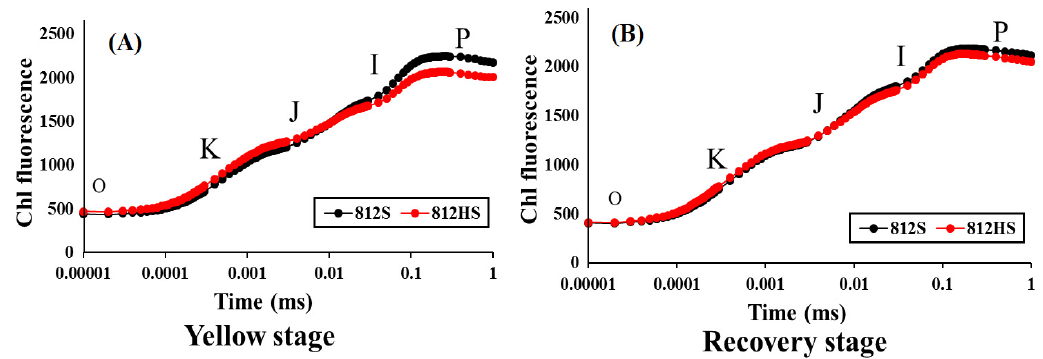
Figure 4. Dark-adapted chlorophyll fluorescence induction (OJIP) in 812HS and 812S leaves conducted on the yellow stage ( A ) and recovery stage ( B ). The time scale is plotted on a logarithmic (0.01 ms to 10 ms).